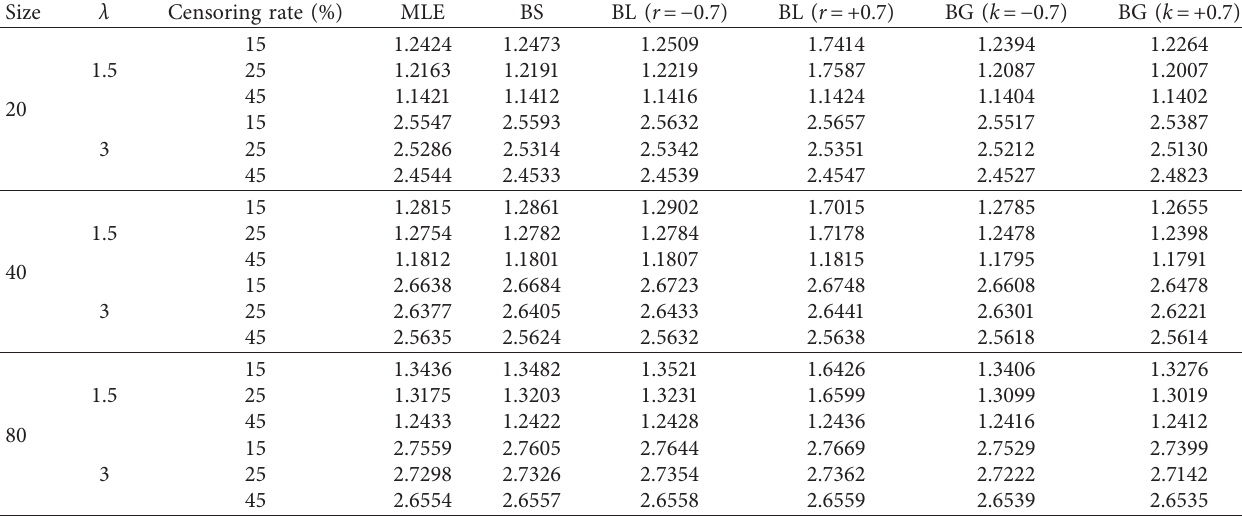
Table 1: Estimations of λ with a cure fraction based on interval-censored data.